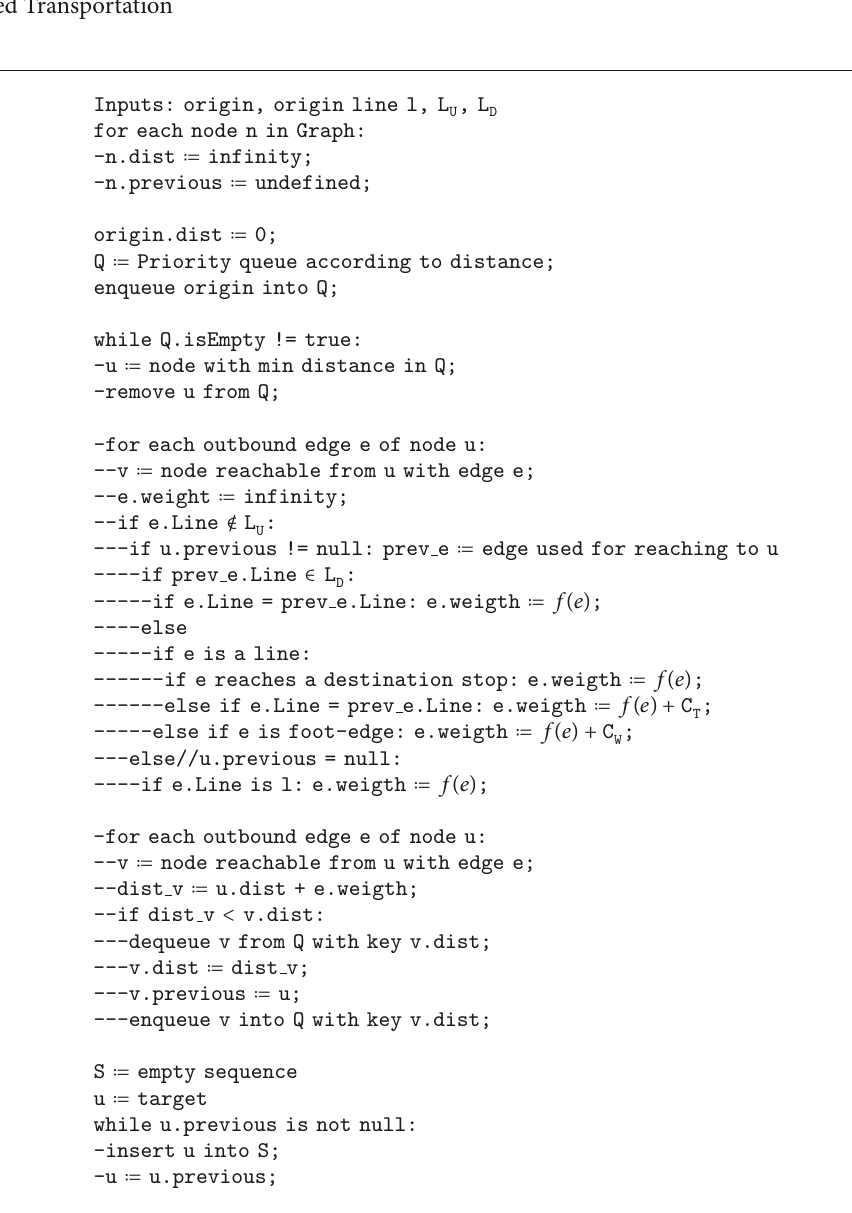
Algorithm 1: Finding routes containing one transfer.